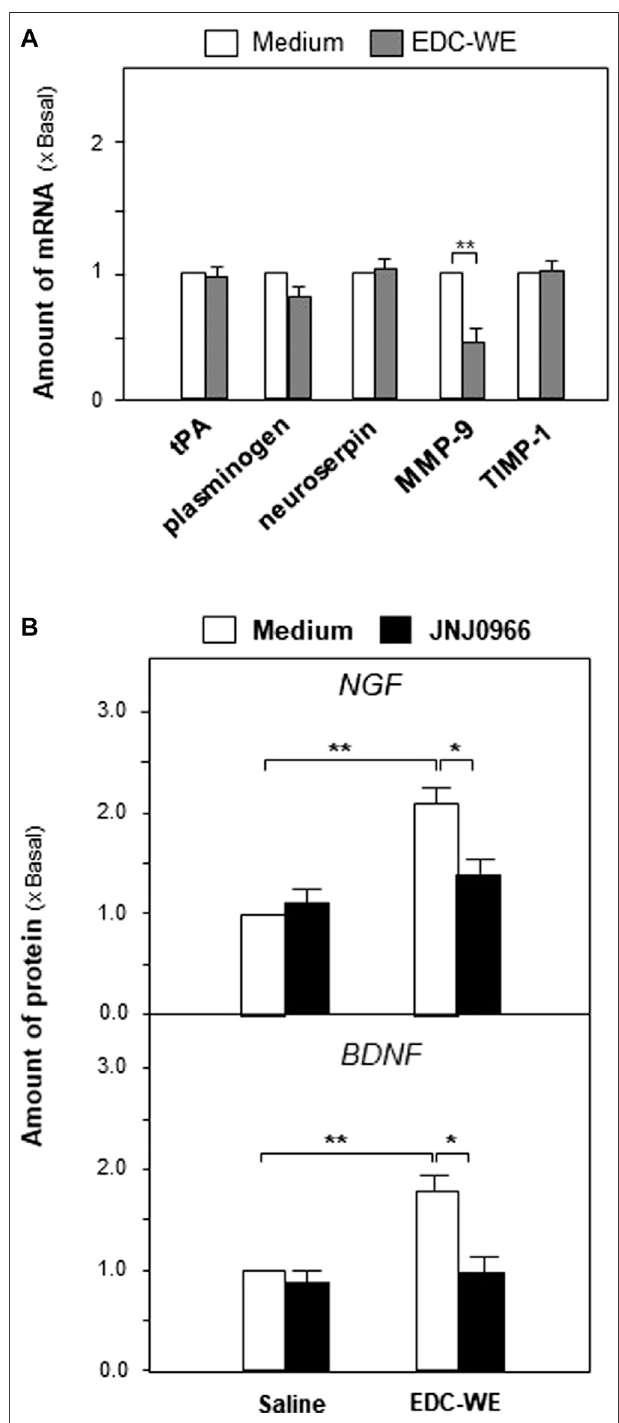
FIGURE 6 | The aqueous extract of Elaphuri Davidiani Cornu (EDC) increased neurotrophic factor expressions via the regulation of the metabolic pathway of neurotrophic factors in mouse astrocyte primary cultures. (A) : The transcriptional levels of proteases accounting for neurotrophic factor metabolism were determined by qPCR analysis in mouse astrocyte primary cultures treated with the aqueous extract (EDC-WE) (3 μ g/ml) for 24 h (B) :